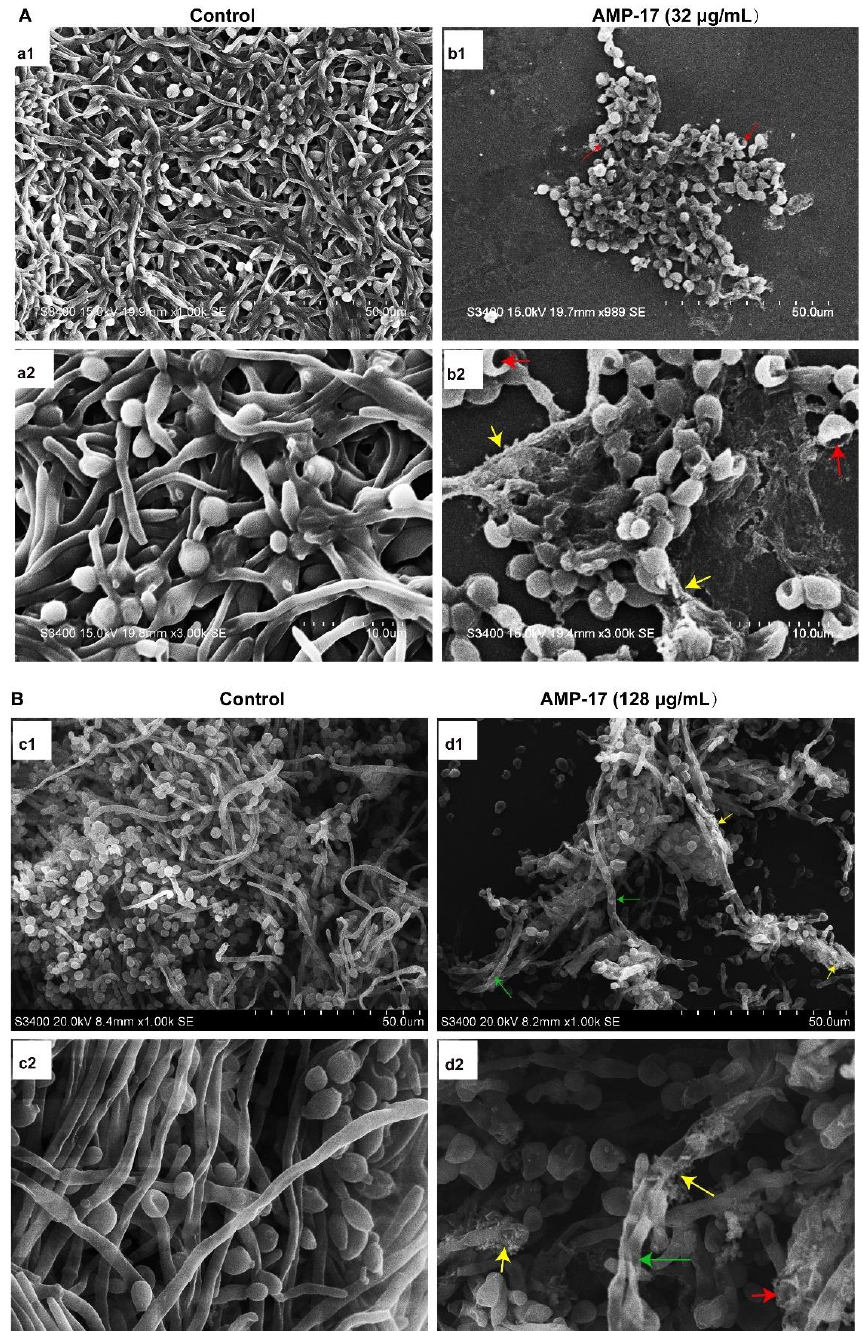
Figure 3. SEM images showed AMP-17-inhibited biofilm formation and mature biofilms in C. albicans . ( A ) Inhibitory effect of 32 µ g/mL AMP-17 on biofilm formation. Biofilms were inhibited when exposed to AMP-17 with the appearance of broken yeast cells (red arrows), rough surfaces (yellow arrows), and the avoidance of biofilm architecture. ( B ) Anti- preformed biofilm effect of 128 μg/mL AMP-17. Biofilms appeared with abnormal structures including broken yeast cells (red arrows), fractured hyphae (green arrows), and a loosening extracellular matrix (yellow arrows). The biofilms were visualized under magnification of 1000× (a1 – d1) and 3000× (a2 – b2).